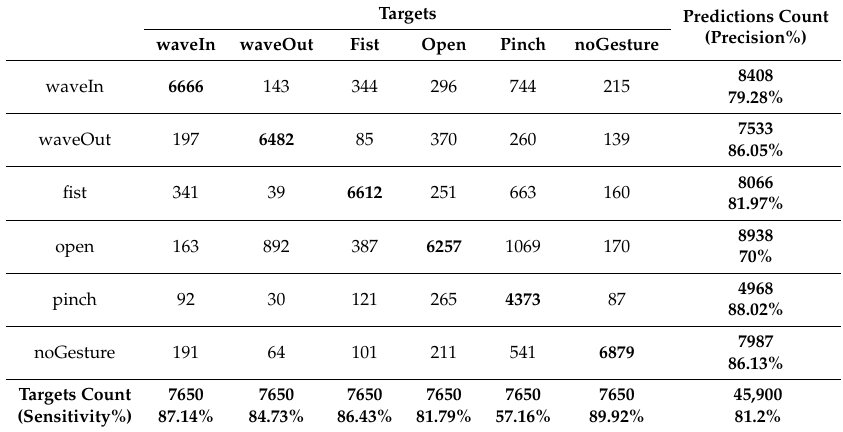
Table 9. Confusion matrix of experiment 3 for the user-general model. Rotation of the bracelet = YES (on the test set), orientation correction = YES . Best result with four synchronization gestures ( sync = 4 ) to select the maximum average energy sensor s x . Classification accuracy = 81.2%.